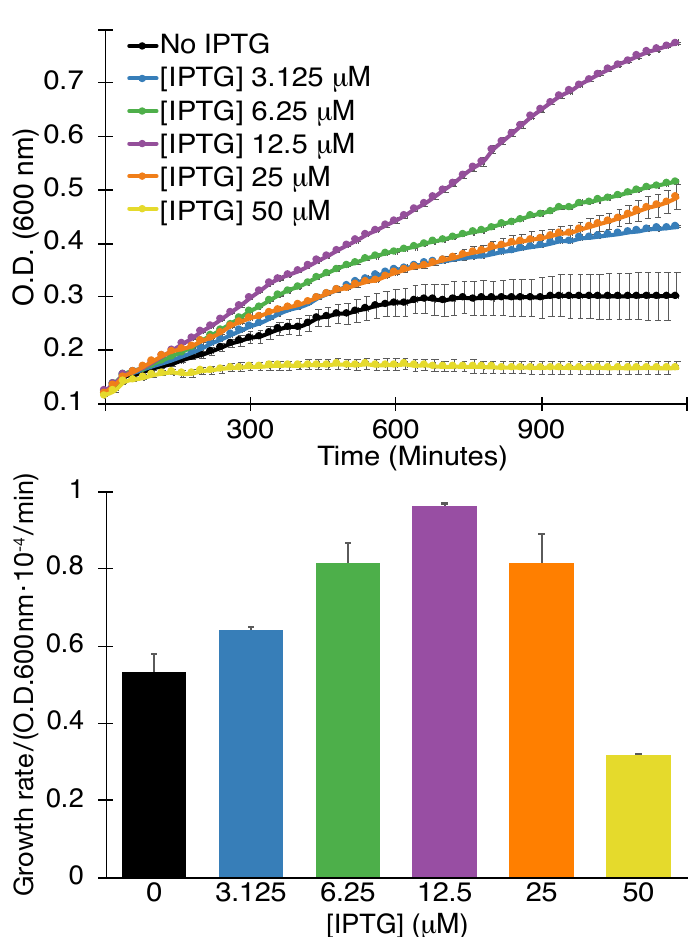
Figure 2. Positive assay. Growth curves ( top ) and maximal growth rates ( bottom ) of K + -uptake deficient bacteria as a function of SARS-CoV 3a protein expression, governed by the level of the inducer β - D -1-thiogalactopyranoside (IPTG), as indicated. The analyses were performed in triplicates with indicated standard